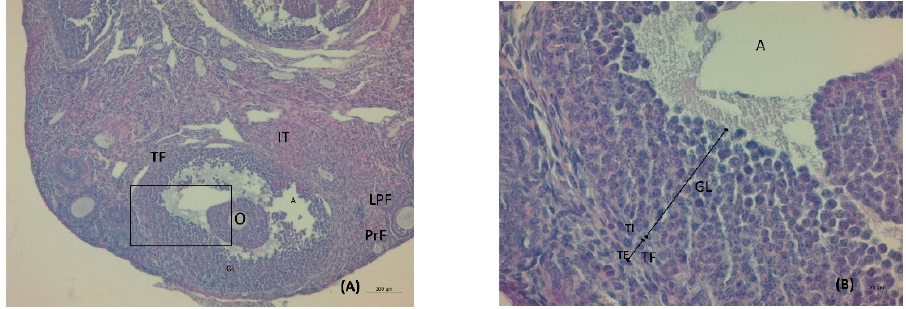
Figure 4. Histological sections of the ovaries of intact mice: tertiary follicle. O: oocyte; GL: granulosa layer; A: antrium; LPF: late primary follicle; PrF: primodial follicle; IT: interstitial tissue; TF: theca folliculi; TE: theca externa; TI: theca interna (H&E; power 100×( A )/400×( B )).